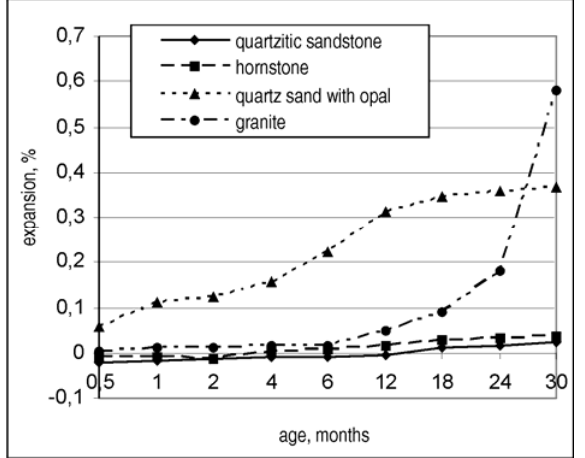
Fig 2 . Expansion of mortar bars containing quartzitic sandstone, hornstone, quartz sand with opal and granite aggregate (ASTM C 227